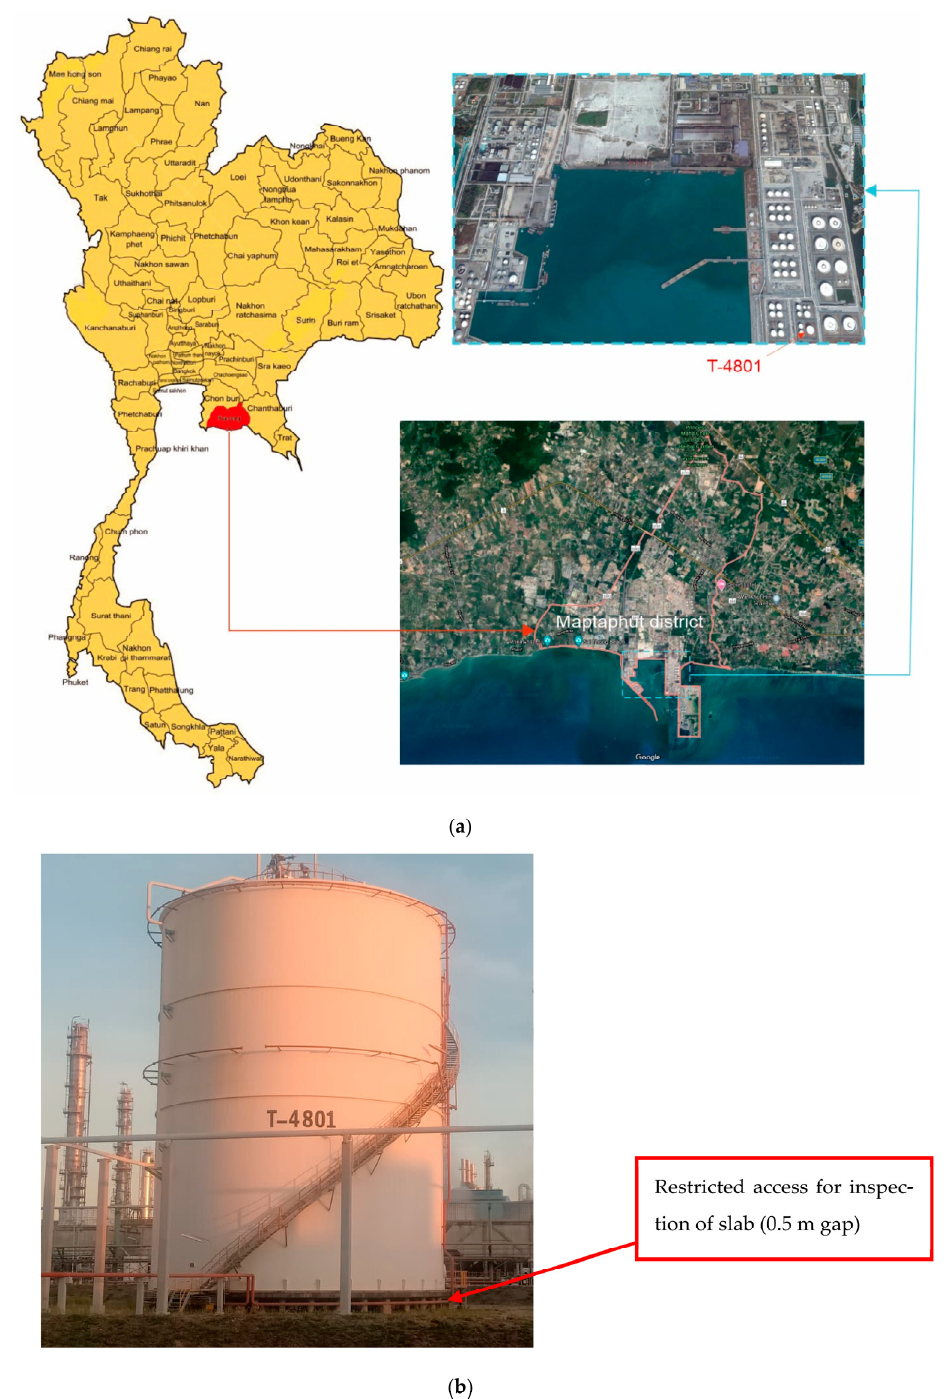
Figure 1. ( a ) Location of T-4801 ethane tank within the Ta Phut Industrial Estate, and ( b ) T-4801 ethane tank [30].